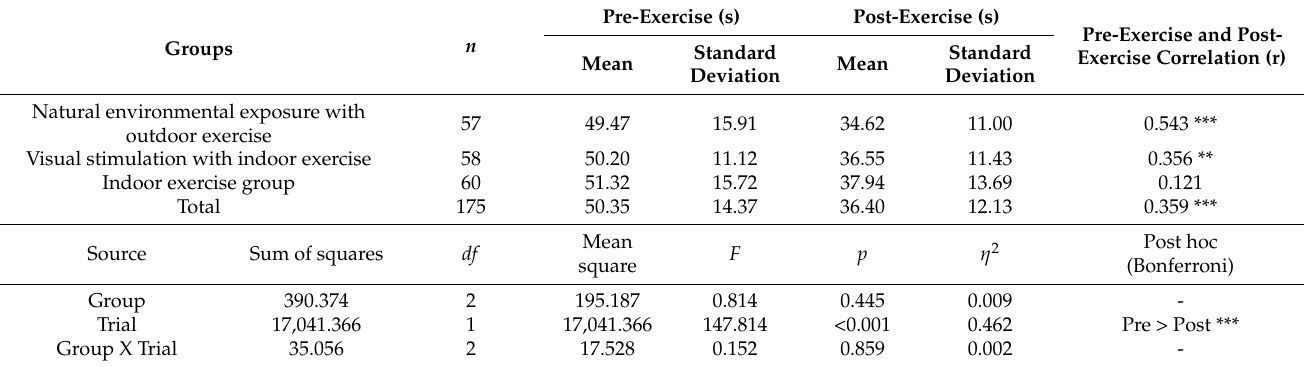
Table 4. Concentration pre- and post-exercise among the three participant